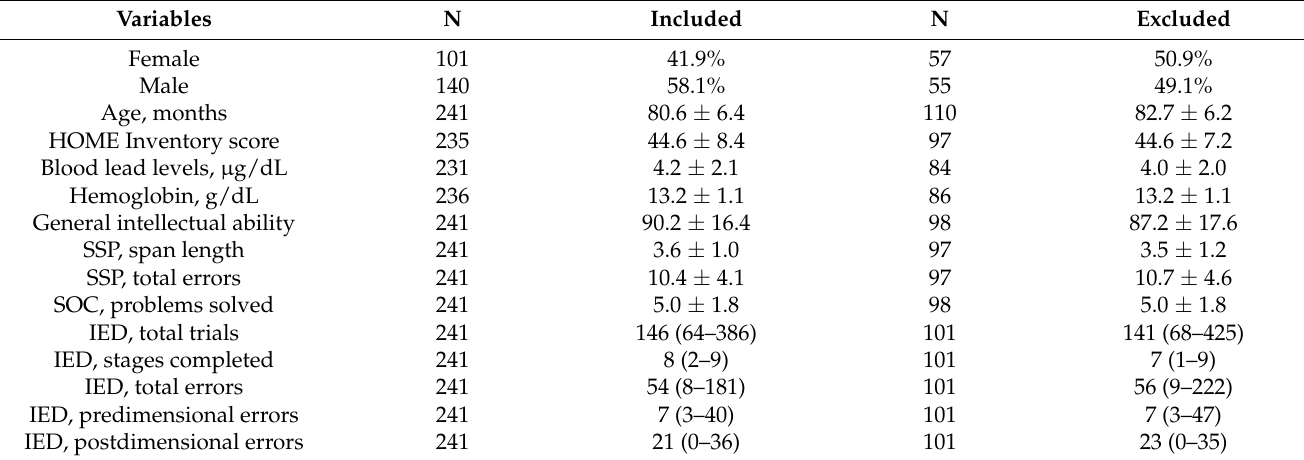
Table 1. A comparison of demographic characteristics and cognitive performance between Montev- ideo children aged ~7 years with urine and cognitive data (included in the study) and those without urine and cognitive data (excluded) ( n =